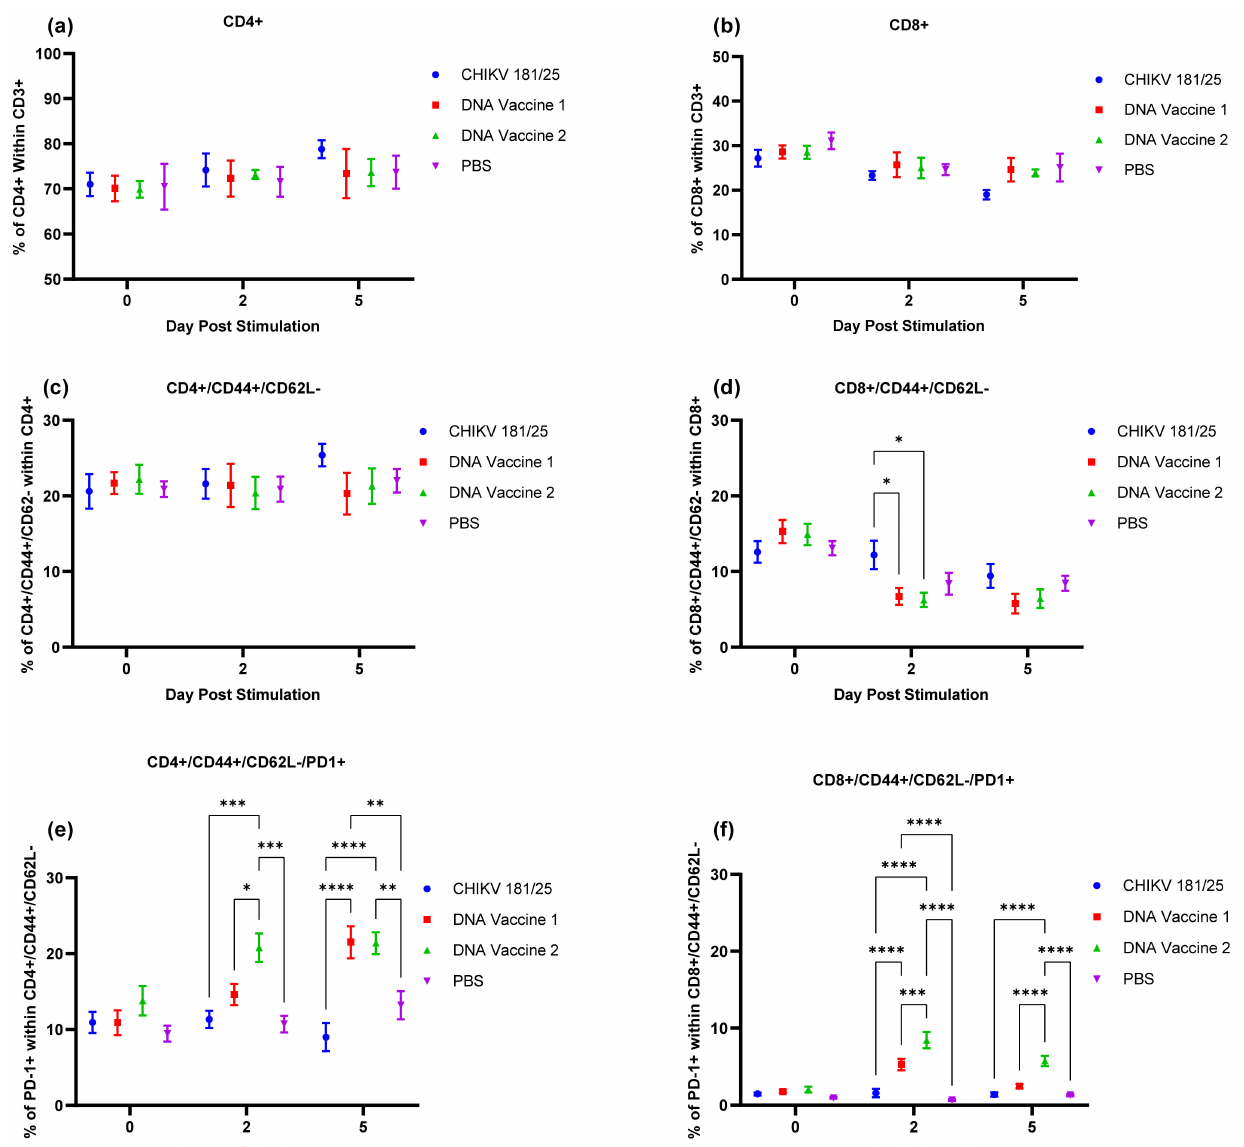
Figure 9. Percent of antigen-specific T cells at baseline and 2- or 5-days post-stimulation with CHIKV 181/25. ( a ) Percent of CD4+ T cells within the total (CD3+) T cell population. ( b ) Percent of CD8+ T cells with the total T cell population. ( c ) Percent of activated (CD44+/CD62l-) cells within the population of CD4+ cells. ( d ) Percent of activated (CD44+/CD62l-) cells within the population of CD8+ cells. ( e ) Percent of PD-1 positive cells within the population of activated CD4+ cells. ( f ) Percent of PD-1 positive cells within the population of activated CD8+ cells. Control = mice immunized with PBS; DNA 1 = mice immunized with DNA vaccine 1; DNA 2 = mice immunized with DNA vaccine 2; CHIKV = mice immunized with the live attenuated CHIKV 181/25 strain. * p < 0.05, ** p < 0.005, *** p < 0.0008, **** p <